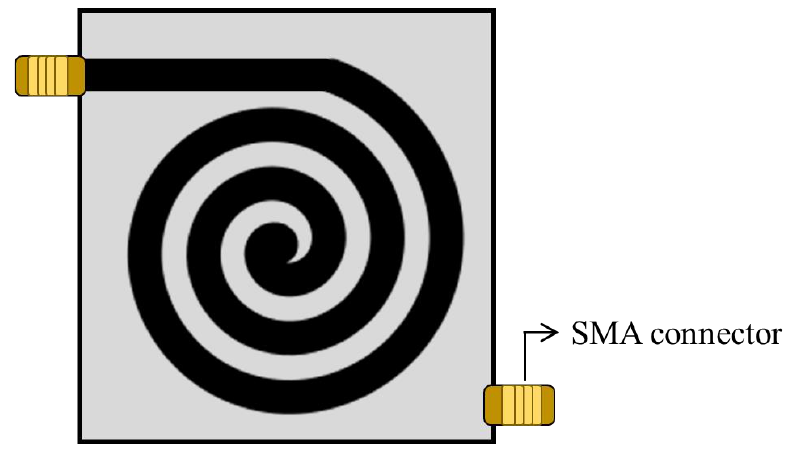
Figure 3. Simplified sketch of spiral antenna design.